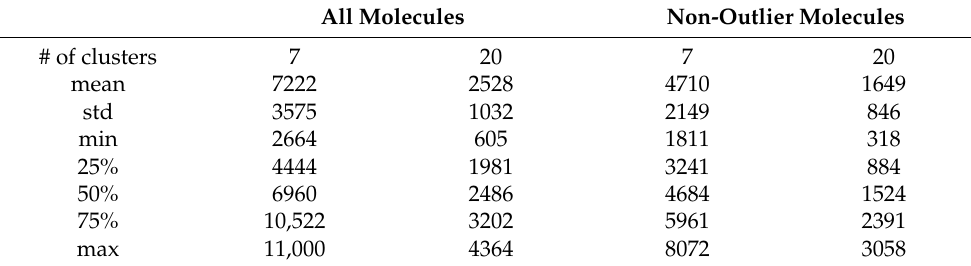
Table 6. Descriptive statistics of the cluster sizes obtained by the UMAP clustering. This algorithm was applied to all molecules and non-outlier molecules show that the size of the clusters is well distributed in both cases. Non-outlier molecules were retrieved at an outlier cutoff of 0.5. The number of clusters required was set to either 7 or 20 (see Table 5 for more details about the number of clusters